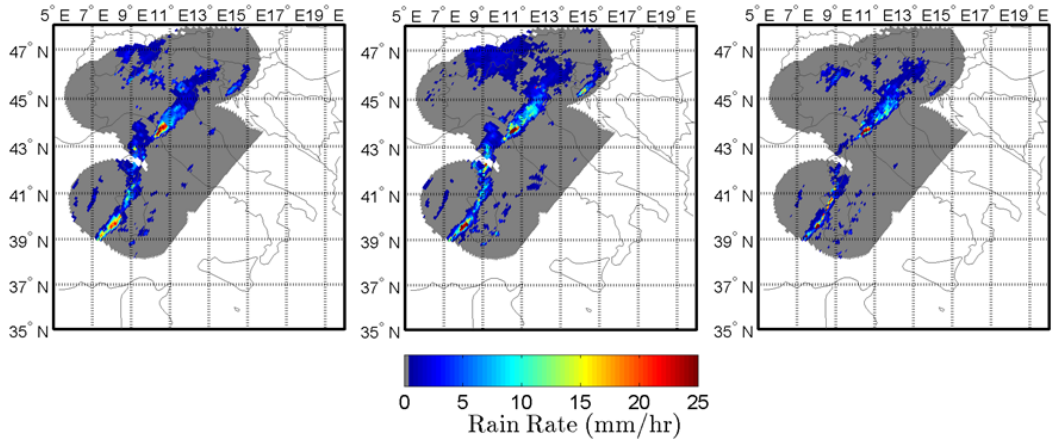
Figure 5. Heavy storm over Livorno (Tuscany region, Italy) on 10 September 2017, at 01:17 UTC. Precipitation estimates from PNPR v3 ( left panel ), GPROF V05 ( middle panel ) and ground radar observations, at 01:20 UTC ( right panel ) are shown. The GMI products are shown only on the area covered by the radar network.